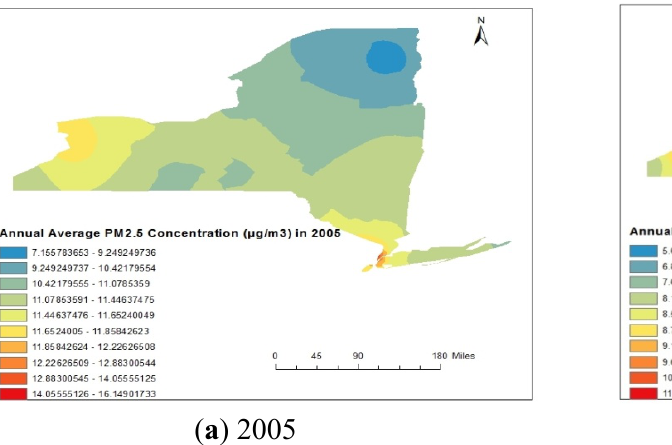
concentrations during 2.5